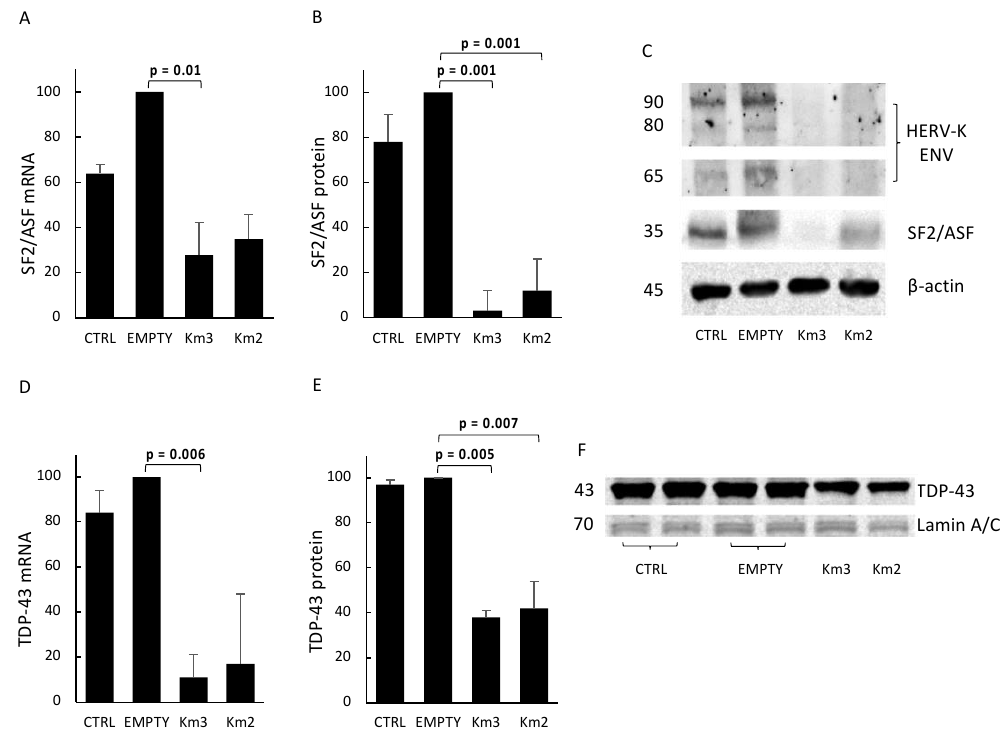
Figure 4. Levels of SF2 and TAR DNA-binding protein 43 (TDP-43) mRNAs and proteins in LNCaP transfected either with the empty plasmid or with the pX601-Km(3-2) gRNA plasmid. ( A ) Mean levels of splicing factor 2/alternative splicing factor (SF2/ASF) mRNA in three independent experiments, run in duplicate, reported as percent of the value of empty-treated cells in each experiment. For controls of specificity, see Methods. ( B ) Mean values of the SF2/ASF protein, as detected by Western blot in three different experiments. The data are reported as mean intensity of the specific stain of the band of interest, normalized with respect to that of the β -actin reference protein; see Methods for details. ( C ) Representative Western blot assay showing SF2/ASF and HERV-K Env proteins in LNCaP transfected either with the empty plasmid or with the pX601-Km(3-2) gRNA plasmid. After blotting, the relevant bands were recognized by anti-SF2/ASF and anti-HERV-K Env mAbs, respectively, as described in Methods. Lane 1: untreated LNCaP cells. Lane 2: LNCaP treated with empty SaCas9 plasmid. Lane 3: LNCaP treated with Km3 gRNA-SaCas9 plasmid. Lane 4: LNCaP treated with Km2 gRNA-SaCas9 plasmid. ( D ) Mean levels of TDP-43 mRNA, run in duplicate, and reported as percent of the value of empty plasmid-treated cells in each experiment. For controls of specificity, see Methods. ( E ) Mean values of the TDP-43 protein, as detected by Western blot in three different experiments. Evaluated as mean intensity of the stain of the band of interest, normalized with respect to that of the reference protein; see Methods for details. In ( E , F ), to ensure equal protein loading, the anti-Lamin A/C mAb was used, instead of the anti- β -Actin mAb, to avoid the overlapping of the staining of two proteins of similar MW. ( F ) Representative Western blot assay showing TDP-43 protein, as recognized by an anti-TDP-43 pAb, as described in Methods. Lanes 1–2: untreated LNCaP cells. Lanes 3–4: LNCaP treated with gRNA-free SaCas9 plasmid. Lane 5: LNCaP treated with Km3 gRNA-SaCas9 plasmid. Lane 6: LNCaP treated with Km2 gRNA-SaCas9